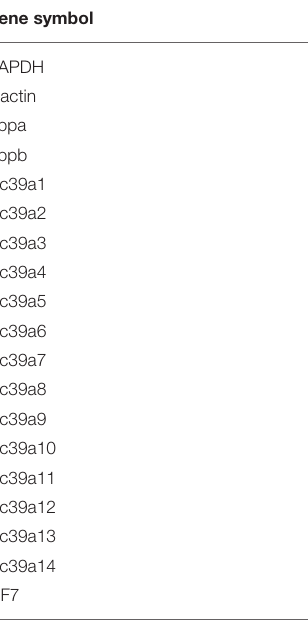
TABLE 2 | Primers designed for